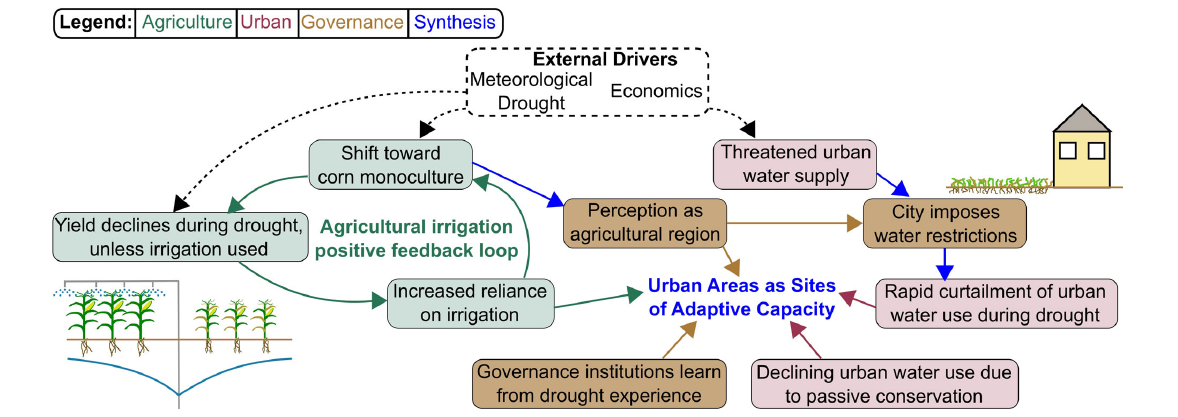
Fig. 5 . Figure outlining conceptual overview of governance (yellow color), agriculture (green), and urban (gray) analysis, highlighting areas of synthesis